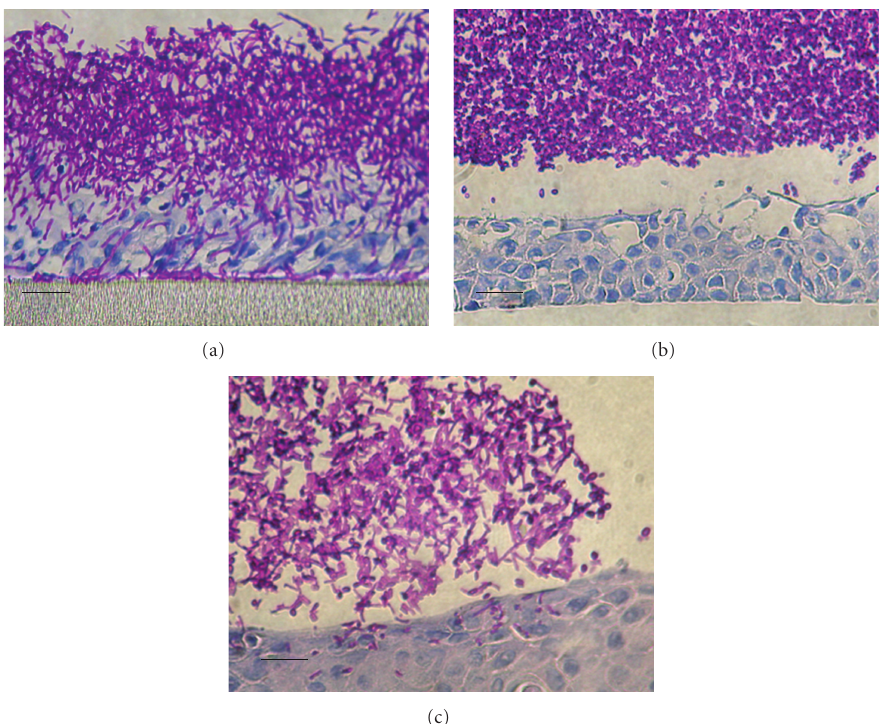
Figure 1: Photomicrograph of C. albicans SC5314 and C. dubliniensis CD36 infecting oral reconstituted human epithelial (RHE) tissue. (a) C. albicans originally grown in nutrient-rich YPD, note the presence of hyphae and extensive tissue invasion and damage; (b) C. dubliniensis originally grown in YPD, note the absence of hyphae and the limited level of invasion and tissue damage; (c) C. dubliniensis originally grown in Lee’s medium, note the increased level of filamentation and invasion. Scale bars, approximately 25 µ